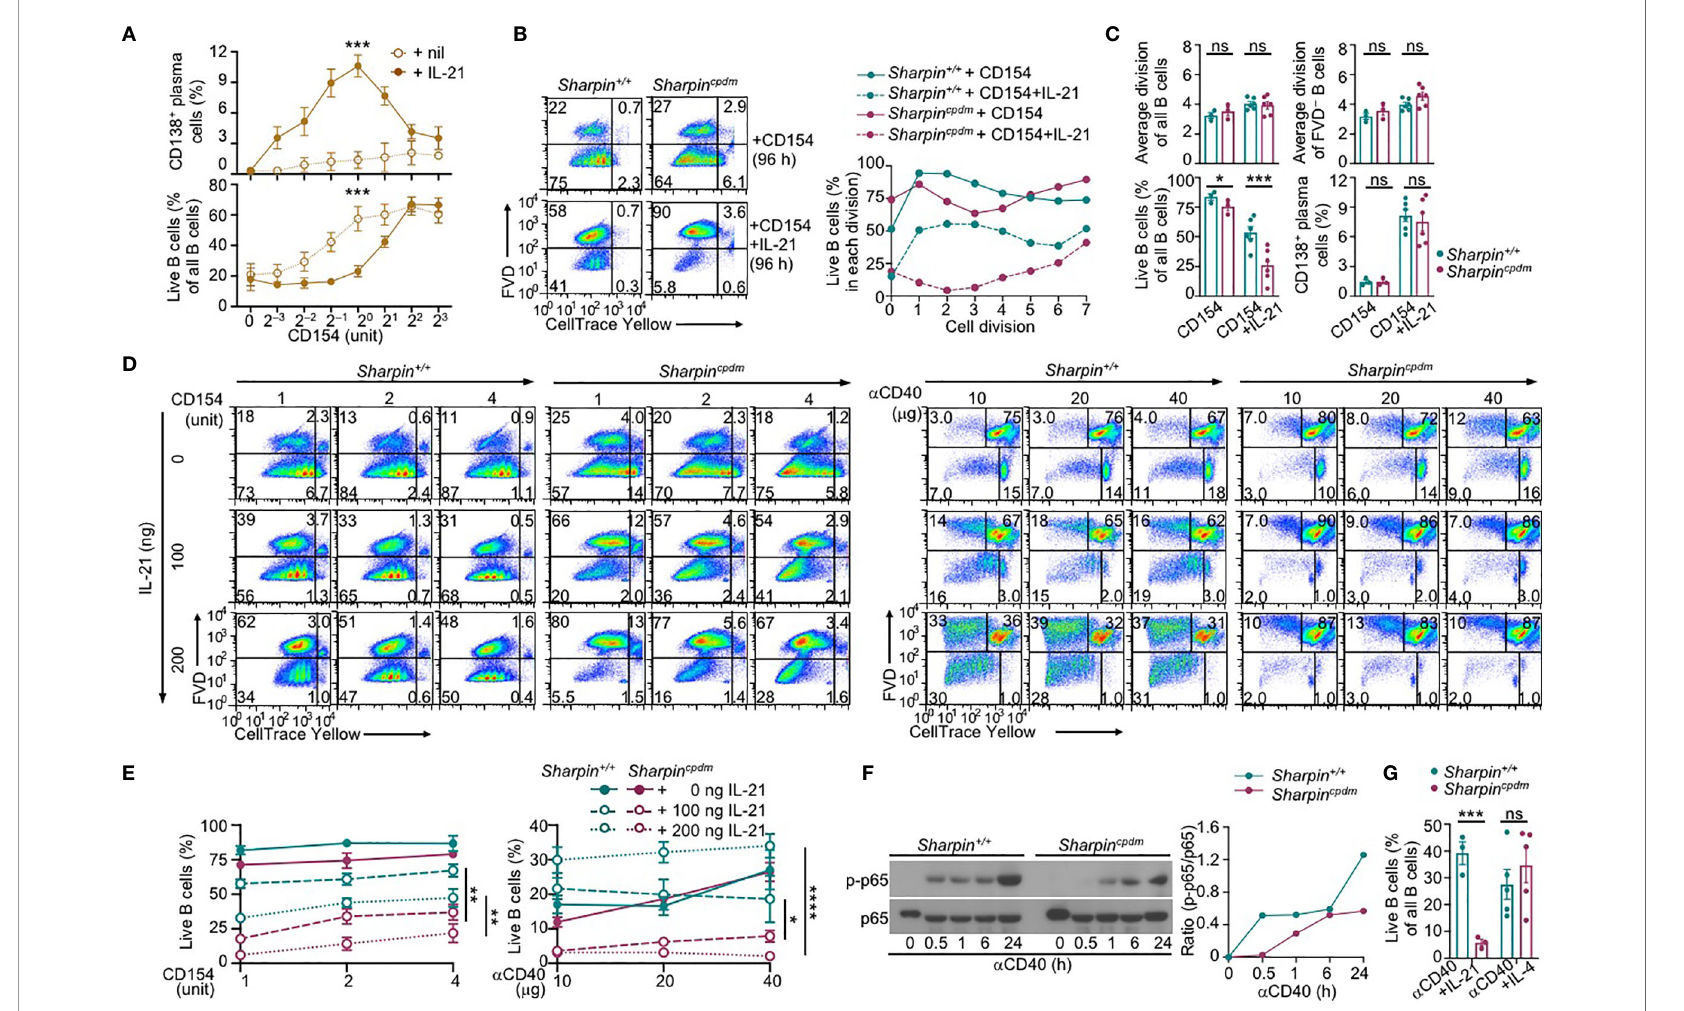
FIGURE 5 | SHARPIN de fi ciency exacerbates IL-21-induced death in CD154-stimulated B cells. (A) Flow cytometry analysis of plasma cell differentiation and B cells viability in C57 B cells stimulated with different doses of CD154, as indicated, in the absence or presence of IL-21 for 96 h (n=4, mean and s.e.m.; data at 1 unit of CD154 were analyzed for statistical differences between Sharpin +/+ and Sharpin cpdm B cells). (B, C) Flow cytometry analysis of proliferation, survival, and plasma cell differentiation of Sharpin +/+ and Sharpin cpdm B cells stimulated with CD154 or CD154 plus IL-21 for 96 (h) Division-linked B cell viability is depicted in (B) , representative of four independent experiments) and average divisions, live B cell proportions, and CD138 + plasma cell proportions were depicted in (C) . (D, E) Flow cytometry analysis of proliferation, survival of Sharpin +/+ and Sharpin cpdm B cells stimulated with CD154 (left panels) or a CD40 (right panels) at indicated doses in the presence of different doses of IL-21 for 96 h (n=3, mean and s.e.m.; data at 4 units of CD154 or 40 m g of a CD40 were analyzed for statistical differences between Sharpin +/+ and Sharpin cpdm B cells). (F) Immunoblotting of phosphorylated p65 and total p65 protein levels in Sharpin +/+ and Sharpin cpdm B cells after stimulation by a CD40 for the indicated time. Representative of two independent experiments. (G) Live cell proportions in Sharpin +/+ and Sharpin cpdm B cells stimulated with a CD40 plus IL-21 or IL-4 for 96 (h) * p < 0.05; ** p < 0.01; *** p < 0.001; **** p < 0.0001;